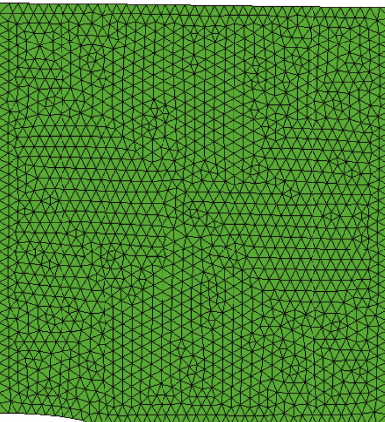
Figure 12: The deformed mesh of the cracked plate, for which the displacement is